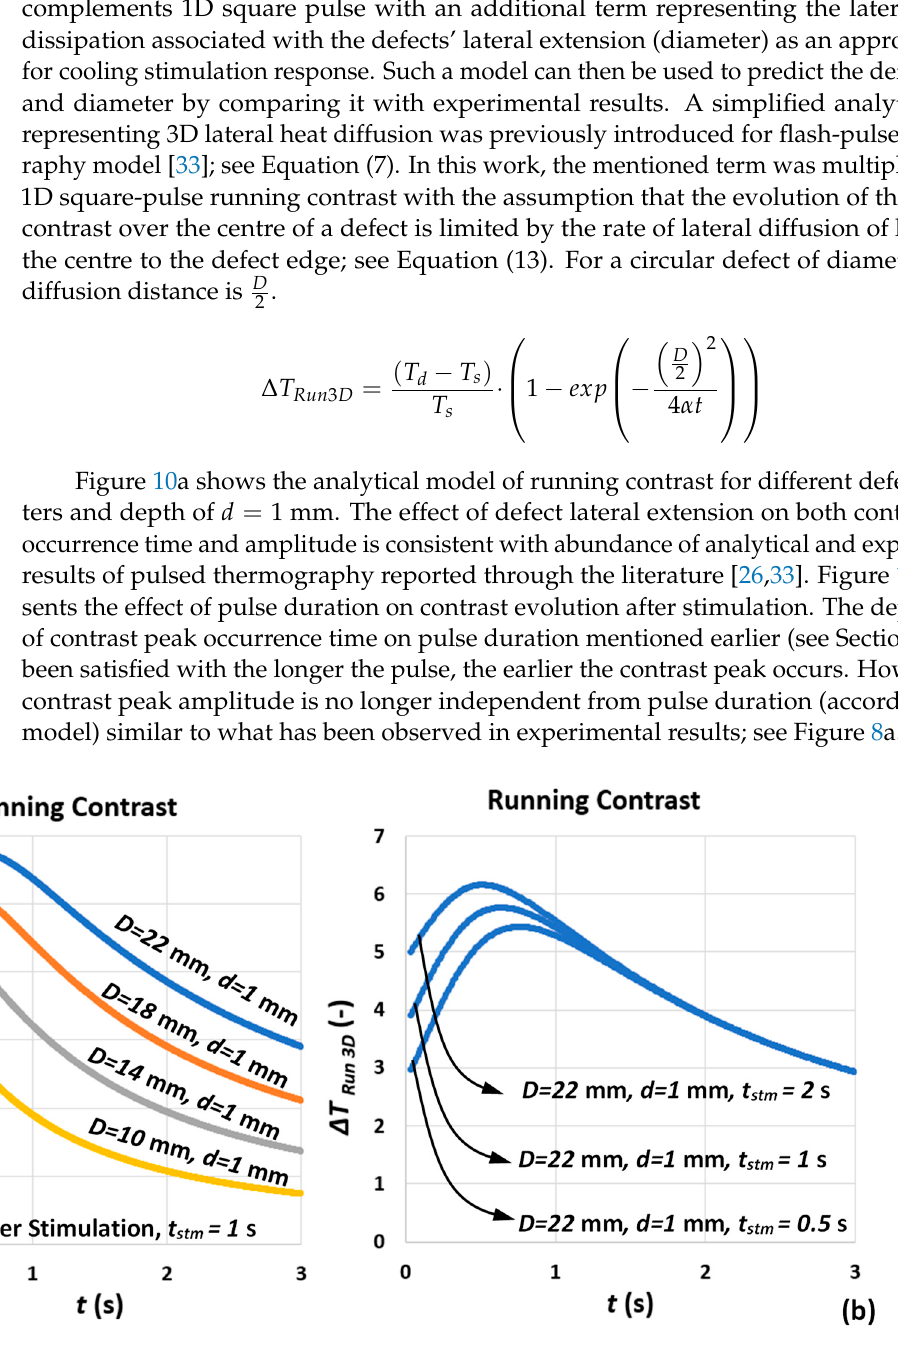
Figure 11. Contrast peak amplitude ratio of ( a ) 0.5 and 1 s and ( b ) 1 and 2 s pulse duration for various defect diameters and depths. In Figure 12, the experimental and model results are compared. The experimental results are extracted from average contrast trends of six tests with approximately 9 pixel/frame test speed. A polynomial degree of 4 fit represents each experimental result trend. The time it takes the cooling burst to pass over one row of defects to another is estimated to be around 0.5 s. The same pulse duration is used to estimate the model re- sults. For the purpose of consistency, both experimental and model results are scaled be- tween 0 and 1. Important observations are as follows: 1. Except for the results of defects of depth 1 mm, there is an offset between experi- mental and analytic contrast peak amplitudes. It was found that this is due to the contrast adjustment process known as “ Automatic Gain Correction ” or “ AGC ” occur- ring in the camera software. In linear AGC, 14-bit digital data are transformed based on a linear transformation function to 8-bit colour intensities. The weakness of linear AGC is, however, quite pronounced in scenes characterised with bi-modal histogram